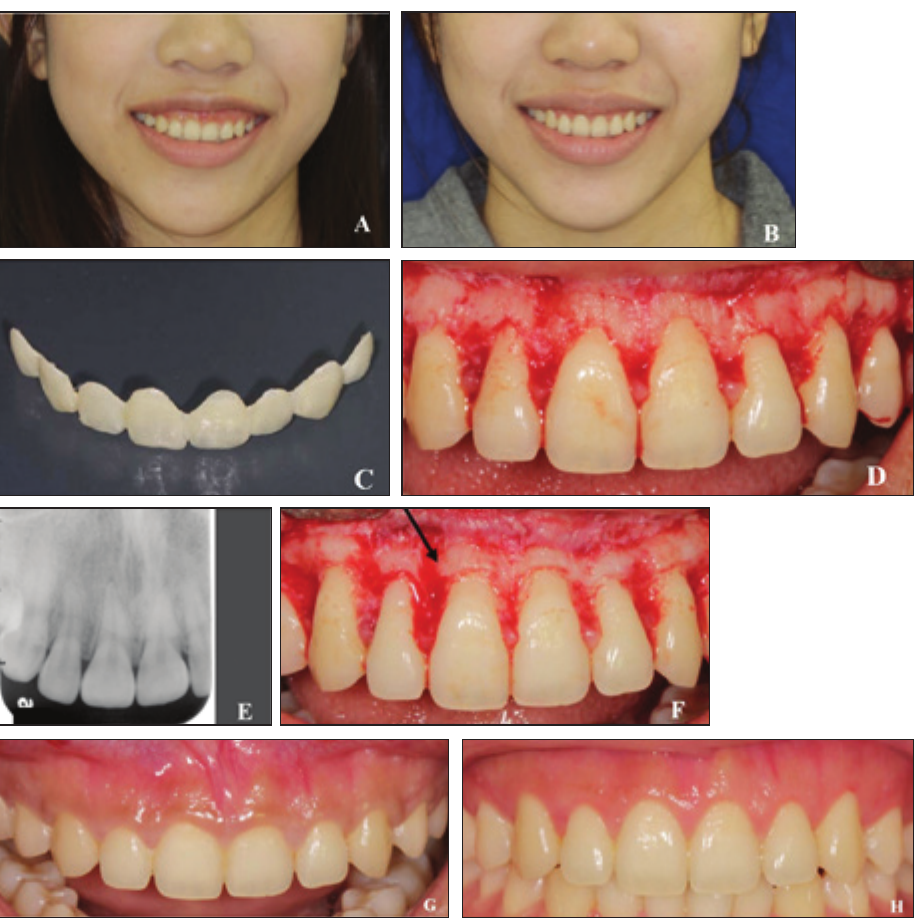
Figure 5. (A, G) Gingival levels of anterior maxillary sextant are determined after appropriate tooth lengths are decided. The patient presented with squat and short clinical crowns with a chief complaint of a gummy smile. Altered passive eruption was diagnosed by thorough examination, including bone sounding and identification of CEJ positions. (C) A diagnostic mock-up is suggested for communication with patients before surgery. The morphology of the mock-up can be adjusted after aesthetic assessment and used as a guide during surgery. (D) For patients with altered passive eruption, periapical films should be obtained to observe whether the CEJ position is consistent with clinical findings. (E, F) An osseous resective procedure should be performed to create 2~3 mm distance between CEJ and the alveolar crest for the development of supracrestal attachment. Ostectomy should be extended to the line angle of the tooth as it is the part most commonly neglected by operators (arrow). (B, H) Aesthetic crown lengthening was performed, and the patient was satisfied with the treatment